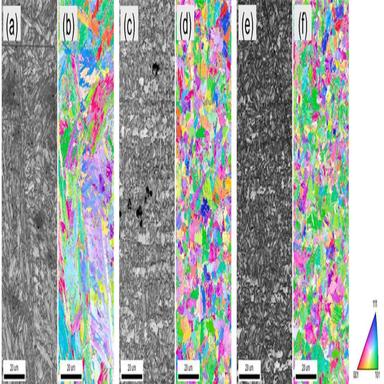
EBSD grain morphology of the ferritic–martensitic microstructure in the order of nugget, SCHAZ, and BM part of JSC1180. (a)(c)(e) image quality map, (b)(d) (f) inverse pole figure map.